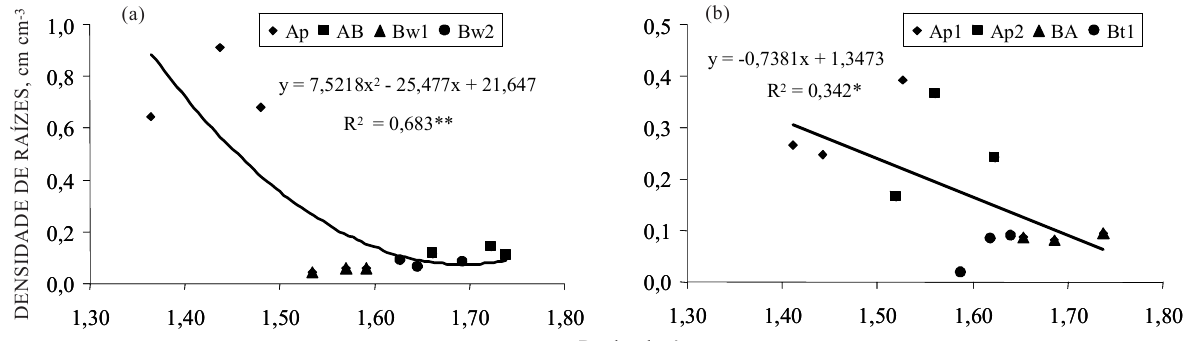
Figura 3. Relação entre densidade de raízes de citros e densidade do solo (Ds), em Latossolo Amarelo (a) e Argissolo Acinzentado (b) de Tabuleiros Costeiros da Bahia, na avaliação de indicadores de horizontes